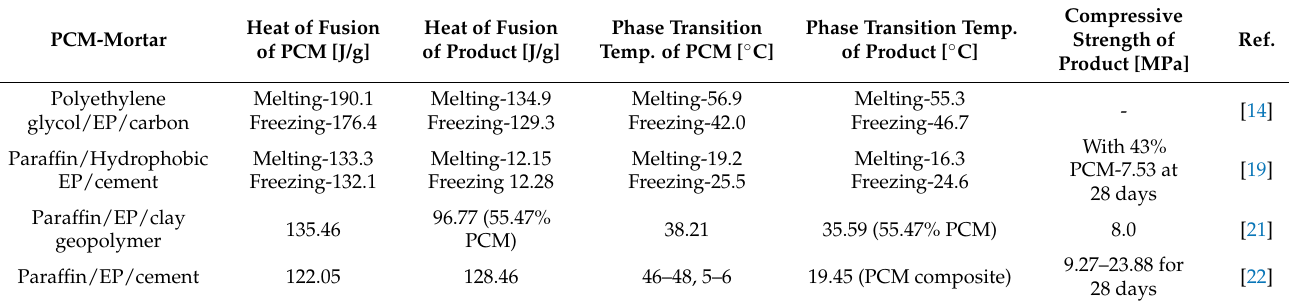
Figure 1. SEM images of expanded perlite ( left ) and paraffin-expanded perlite ( right ) [17]. Table 2. Properties of typical commercial PCMs.